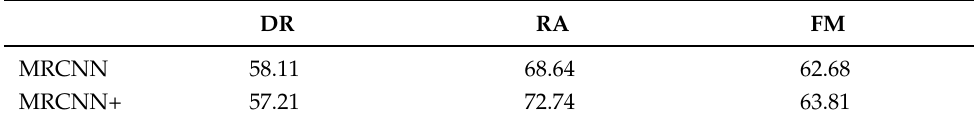
Table 5. Results of the proposed method on ICDAR2015-HTR dataset.